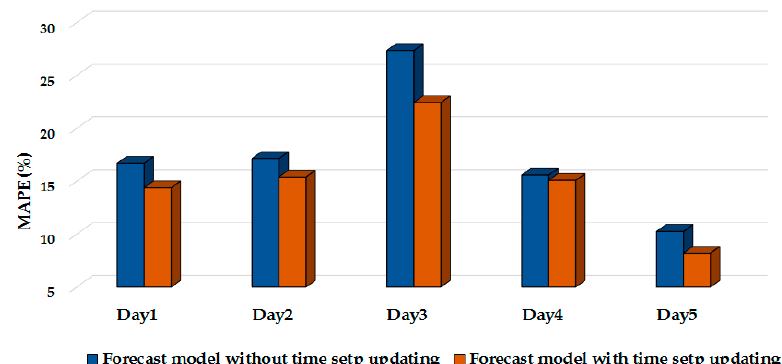
Figure 9. Illustration of the forecast error for training, validation and testing data in a histogram, where 70% of the historical data has been used as training, 13% as validation data and 17% as testing data (5 days testing).